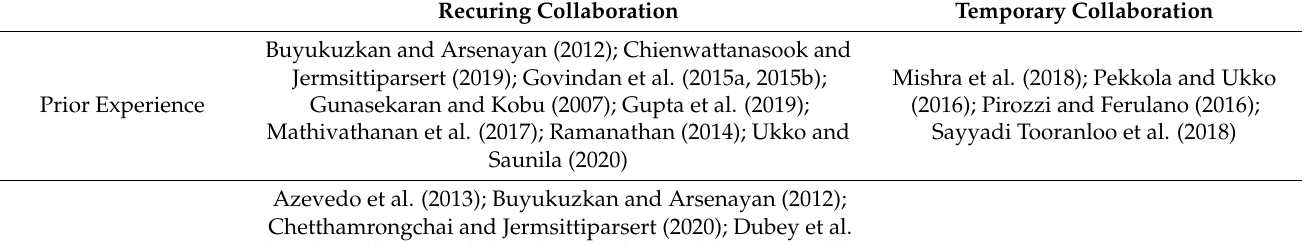
Table 5. Cont. Recuring